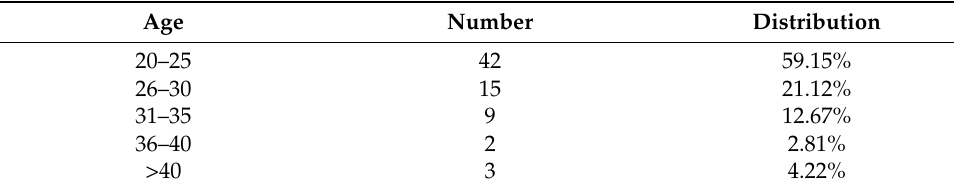
Figure 9. Successful execution of the system. Table 2. Age distribution of the users.